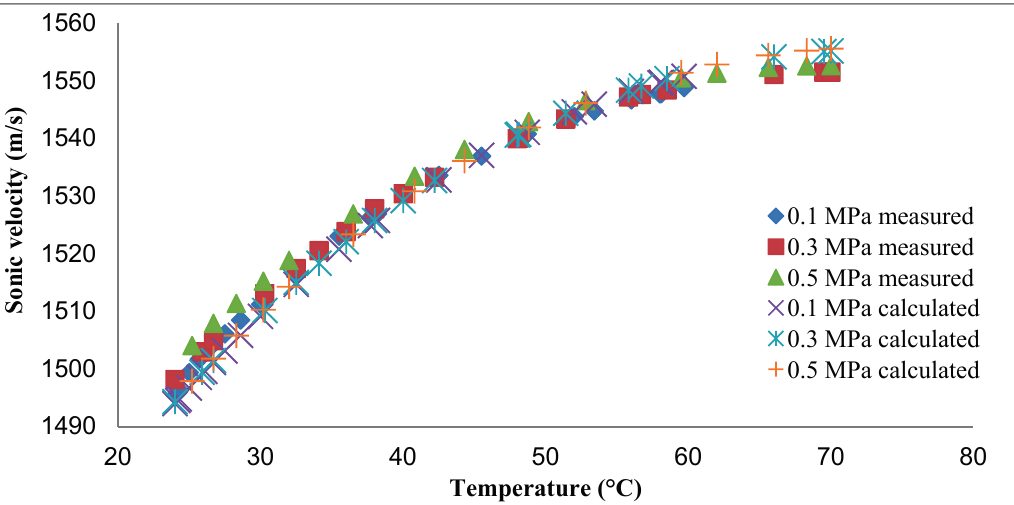
Figure 5. Ultrasonic reference transducer measured sonic velocities and calculated from the Belogol’skii, Sekoyan et al . model using measured temperature and